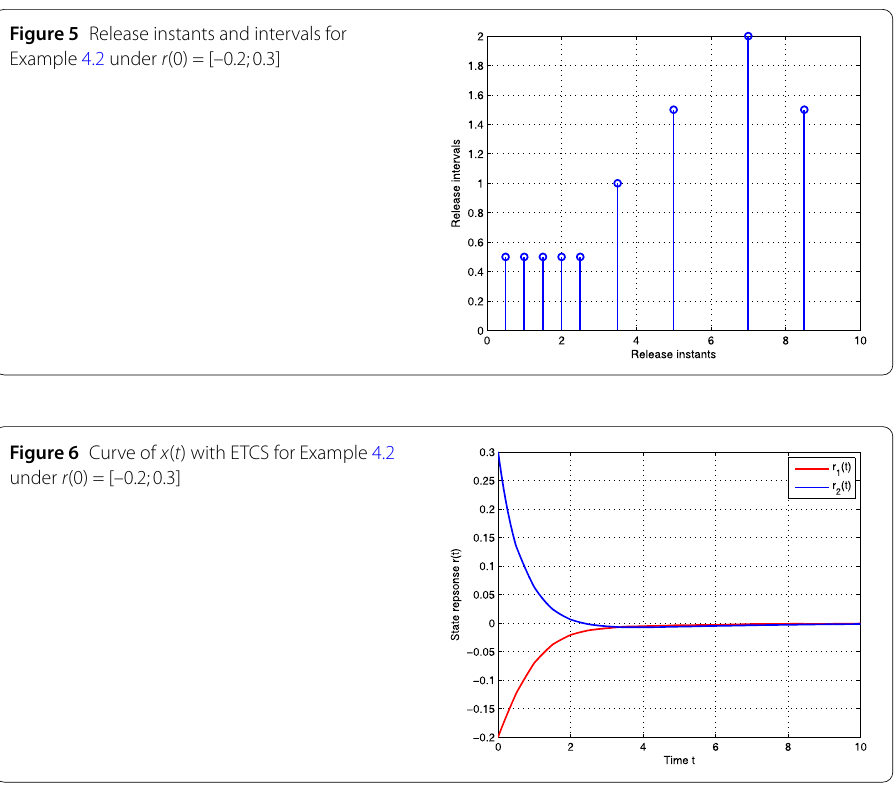
Figure 6 Curve of x ( t ) with ETCS for Example 4.2 under r (0) =